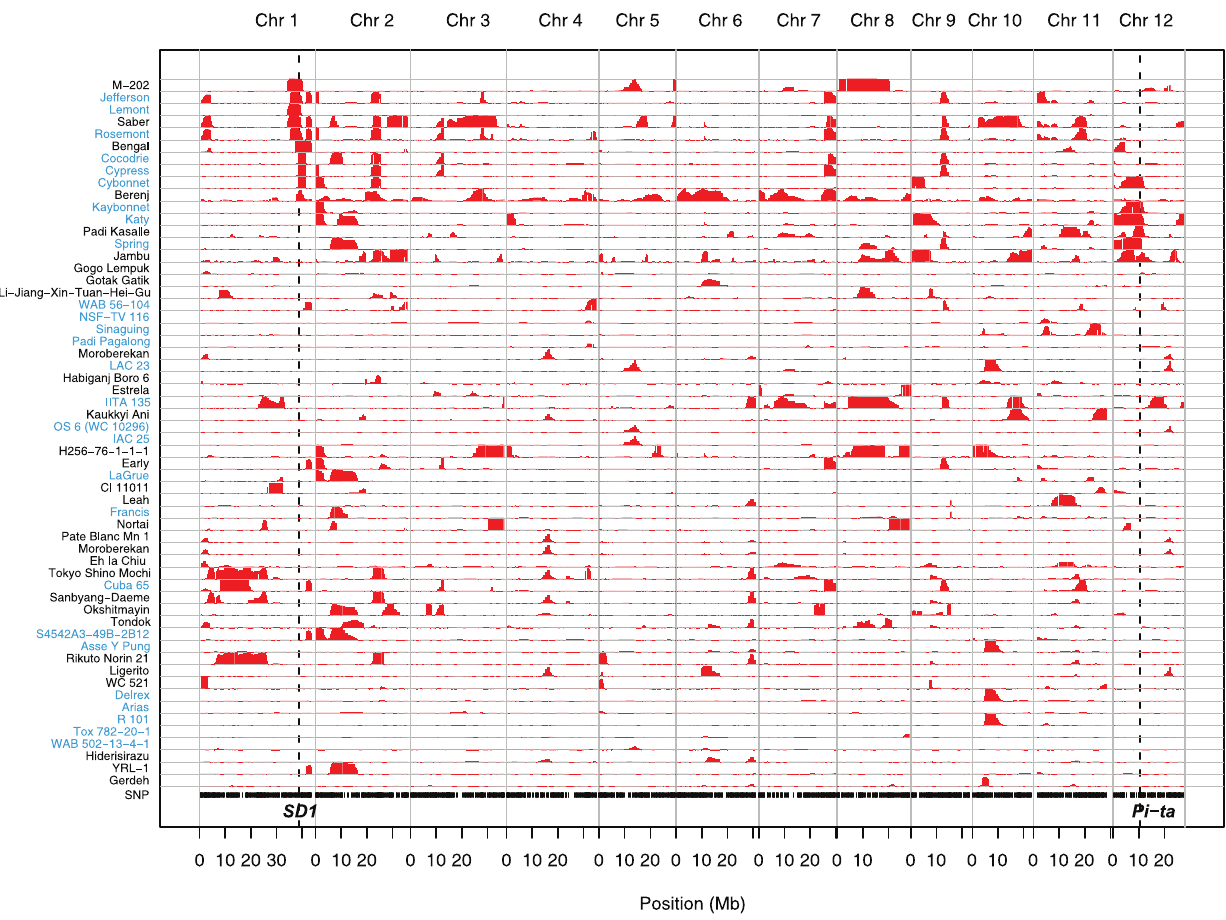
Figure 3. Regions of introgression from indica into tropicaljaponica . SNP positions are shown as black vertical bars across the bottom; vertical grey lines indicate chromosomes; horizontal grey lines indicate accessions; introgressed regions (defined by $ 5 SNPs) shown in red. The height of the red regions corresponds to the probability of introgression, with a maximum value of 1. Only tropical japonica and admixed accessions (where indica component is less than 25%) are plotted in the figure. SD1 and Pi-ta positions shown as vertical dashed lines. Accession IDs are colored in light blue for TRJ and black for admixed accessions.